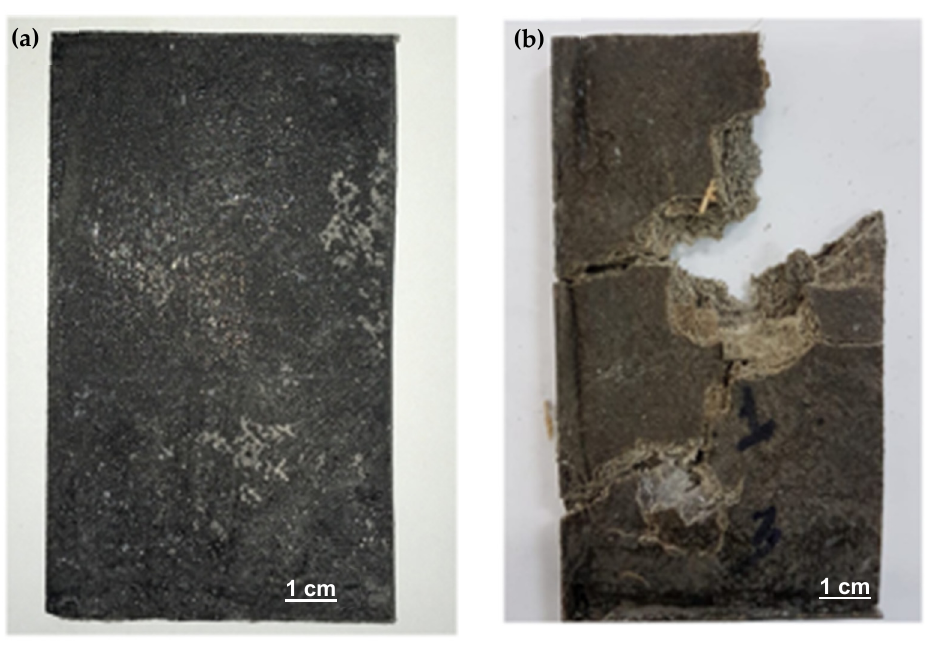
Figure 3. Image of the sample before ( a ) and after ballistic impact ( b ).